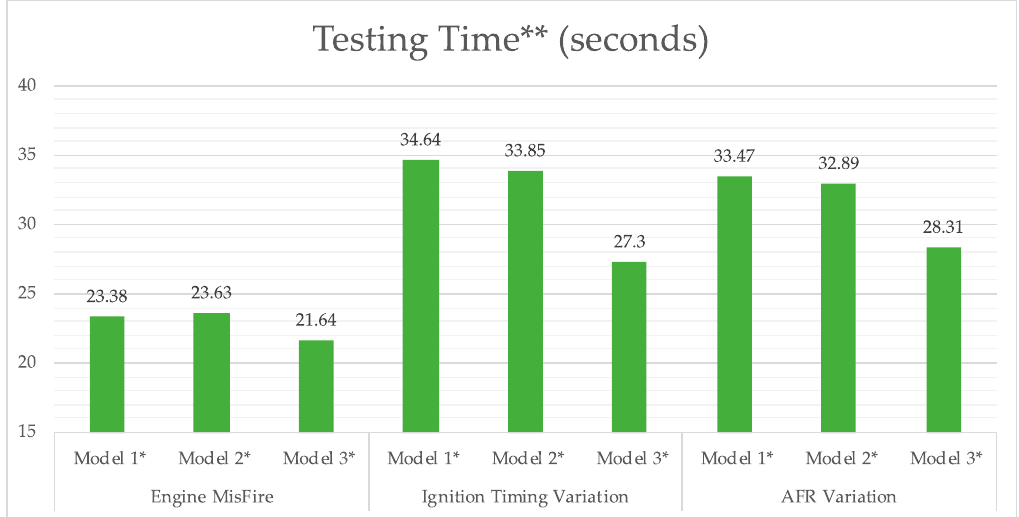
Figure 17. Testing time comparison for the models with three fault conditions. * Model 1, standard classification; * Model 2, Bayesian optimization; * Model 3, PCA with Bayesian optimization. ** Computations were performed on a 2.7 GHz Intel dual Core i5 MacBook pro and programming was done in MATLAB R20.